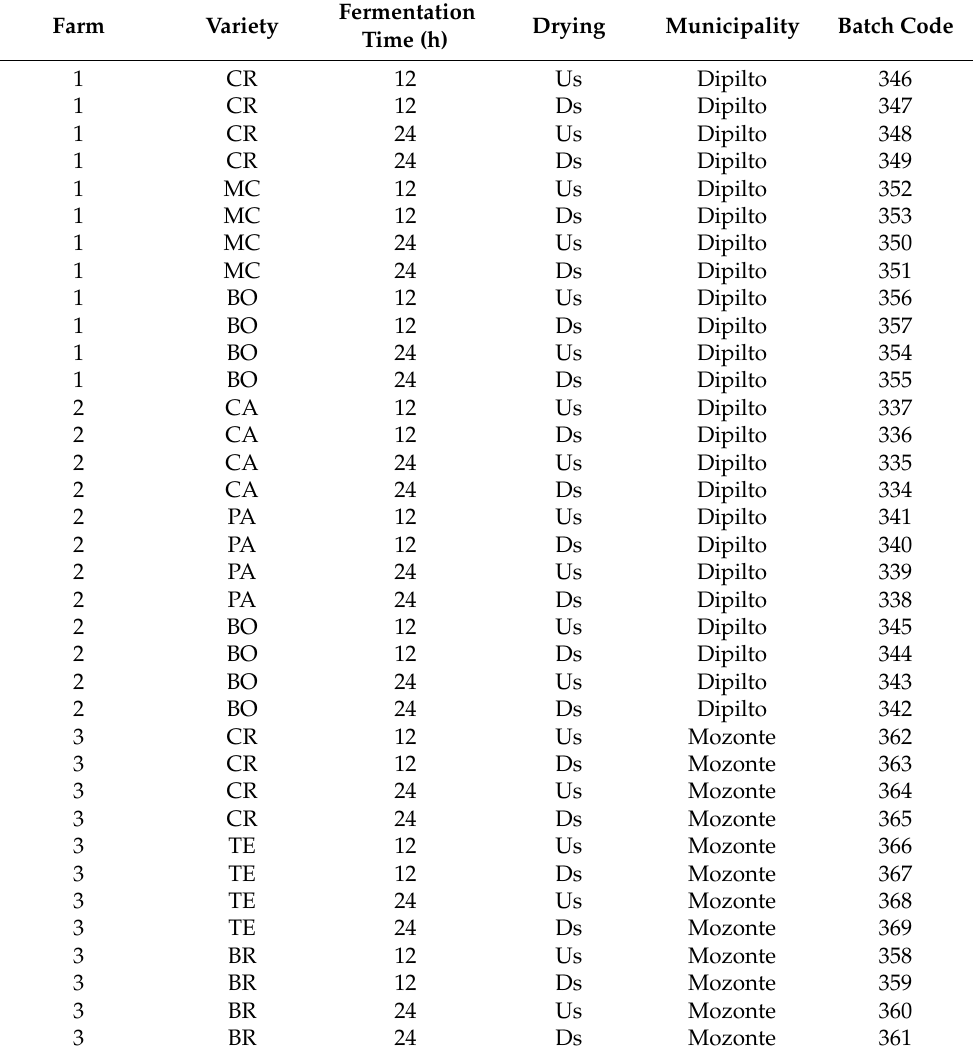
Table 1. List of the Nicaraguan coffee batches